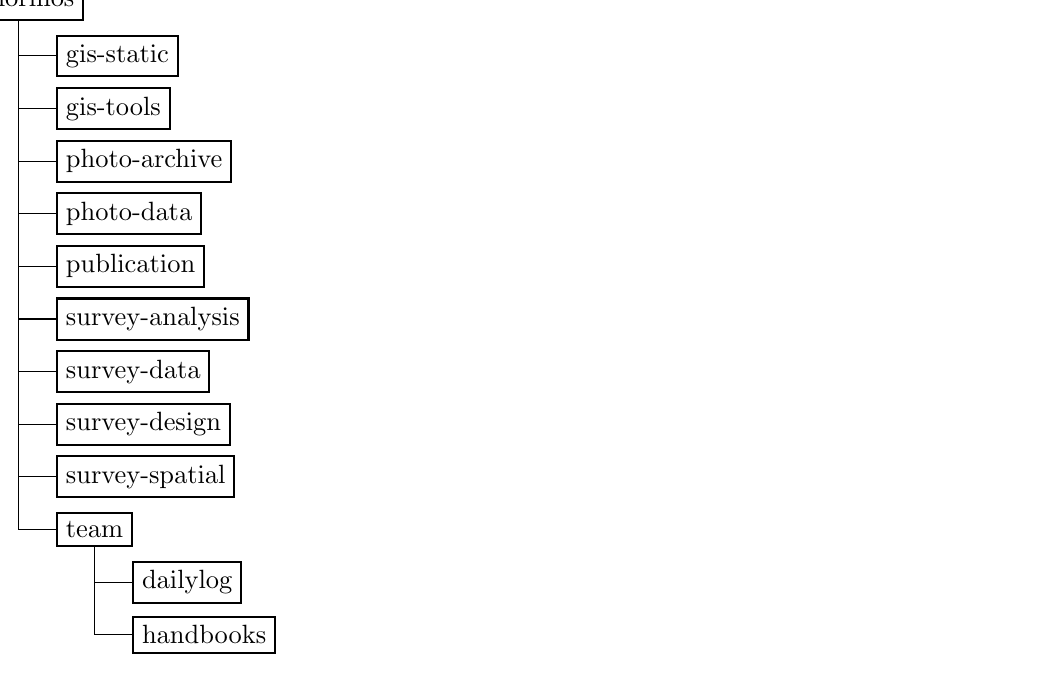
Figure 2. The current structure of the various Project Panormos repositories with an example of the internal structure of the team